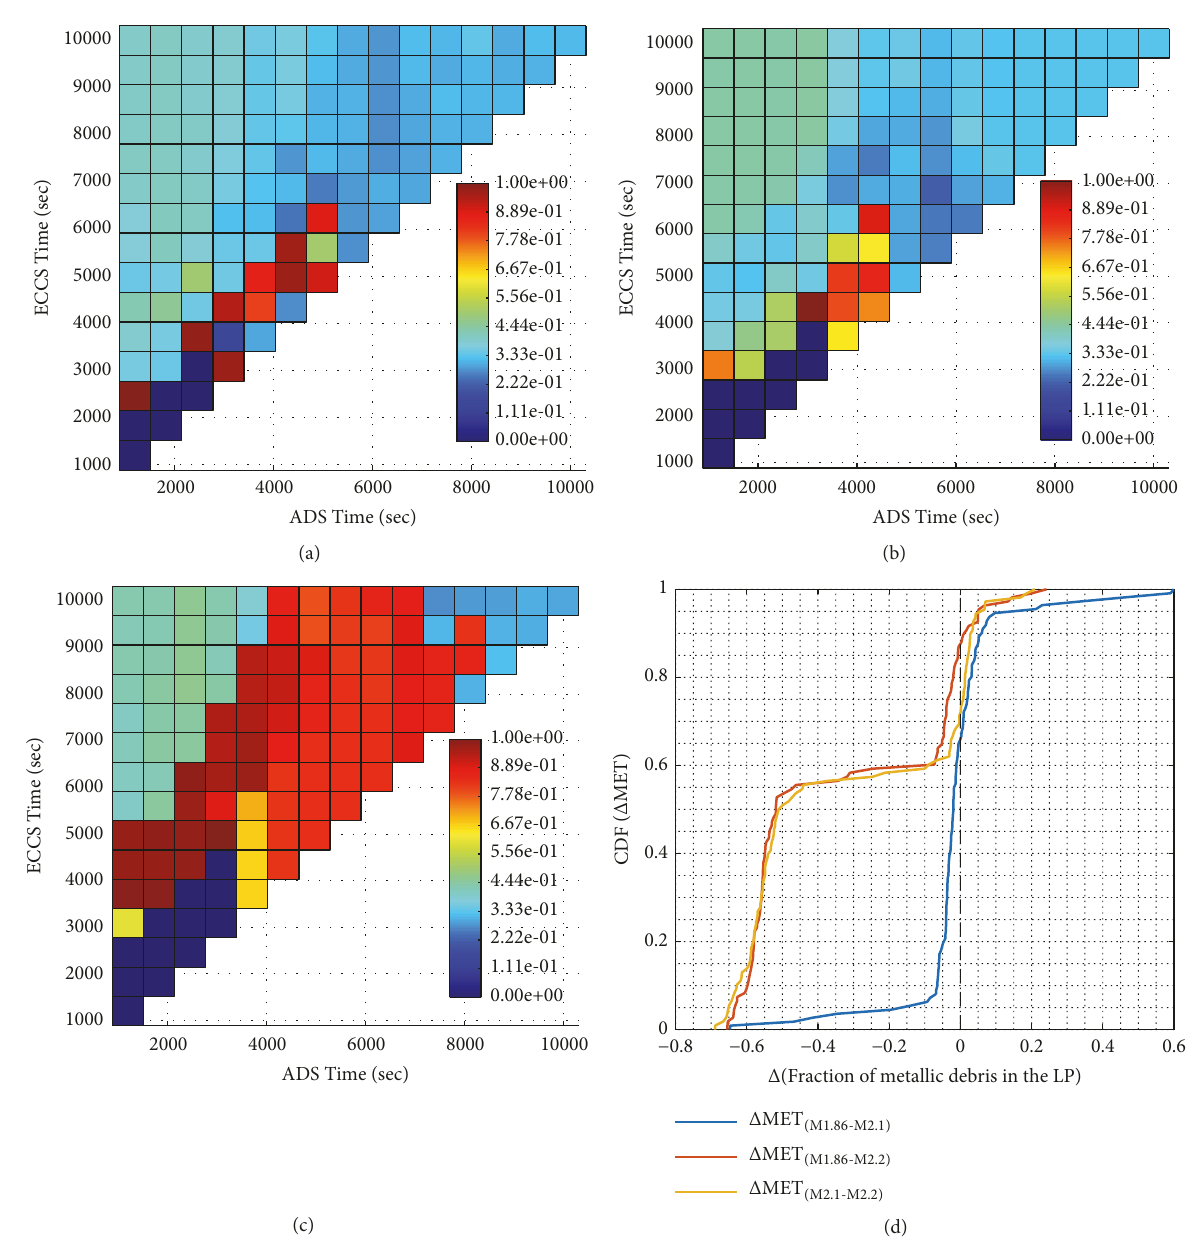
Figure 11: Metallic debris fraction in LP as a function of ADS time and ECCS time obtained with (a) MELCOR 1.86, (b) MELCOR 2.1, and (c) MELCOR 2.2. (d) Cumulative distribution of the differences in the fraction of metallic debris in the LP.